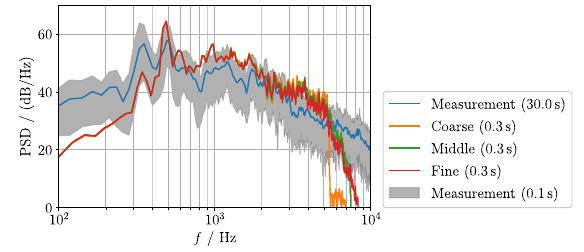
Figure 22. In fl uence of the mesh discretization on the acoustic result at microphone position